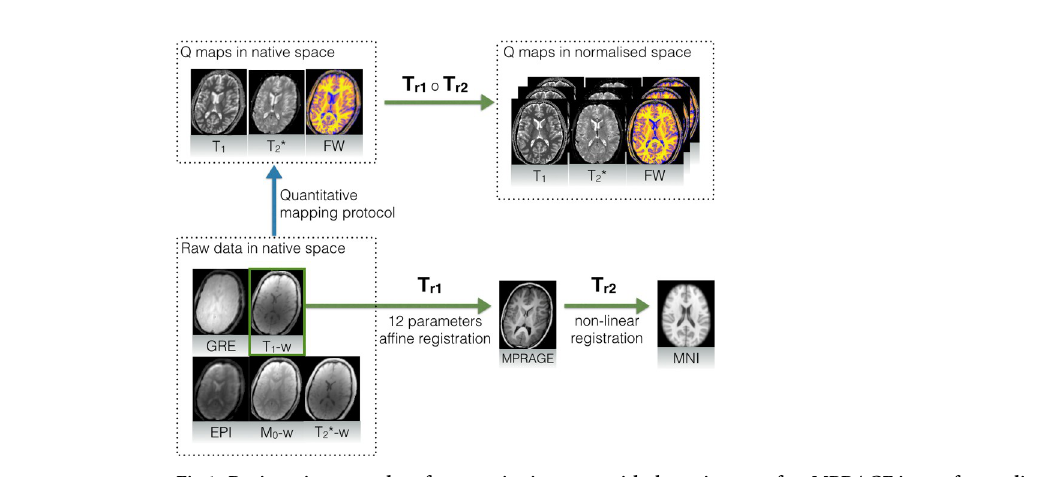
Fig 1. Registration procedure for quantitative maps with the assistance of an MPRAGE image for nonlinear alignment. Raw data is registered to the additional MPRAGE image (T r1 ) which is then non-linearly deformed (T r2 ) to match the MNI template. Composition of both deformations provides the final transformation.